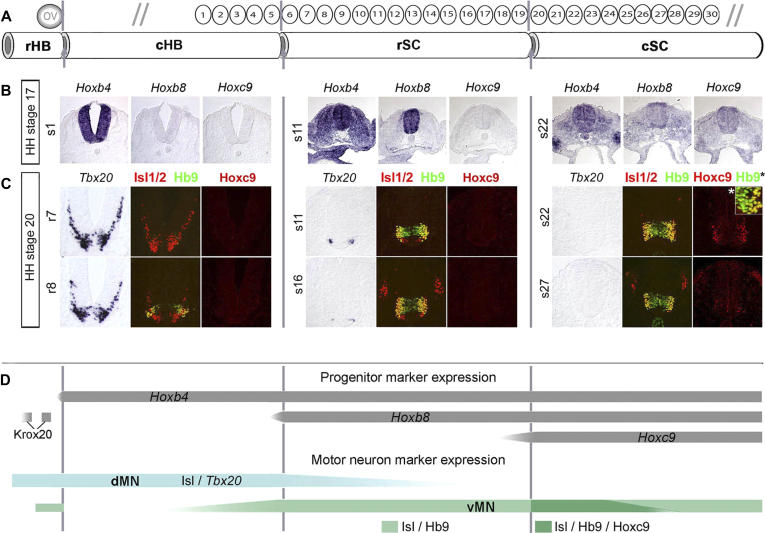
Profiles of
Hox Gene Expression, dMNs, and vMNs in the Hindbrain and Spinal Cord
(A) Schematic figure of the caudal embryonic neural tube divided into four distinct regions along the rostrocaudal axis: rHB; r7 and r8 defined as cHB; the region of the spinal cord located at the level of somite 6–19 defined as the rSC; and the region located caudal to somite 19 defined as cSC.(B) In a stage 17 (30-somite) chick embryo, the rostral borders of
Hoxb4, Hoxb8, and
Hoxc9 expression are located just caudal to the otic vesicle (OV) (at the level of the r6/7 border), at the level of somite 5/6, and at the level of somite 19/20, respectively.
Hoxb4 expression in the absence of
Hoxb8 and
Hoxc9 is characteristic of cells in the cHB (r7 and r8). Expression of
Hoxb4 and
Hoxb8 in the absence of
Hoxc9 is characteristic of the rSC domain, and expression of
Hoxb4, Hoxb8, and Hoxc9 is characteristic of cells in the cSC domain.
(C) In stage 20 (42-somite) chick embryos, the rostral boundaries of expression of
Hoxb4, Hoxb8, and
Hoxc9 in the neural tube are maintained as in a stage 17 embryo (± 1-somite).
Tbx20
+/Isl
+ dMNs are present at high numbers in the cHB and at lower numbers in the rSC. No
Tbx20
+/Isl
+ dMNs are found in the cSC. In contrast, Hb9
+/Isl
+ vMNs are present at high numbers in both rSC and cSC, and at lower numbers in r8 of the cHB. Hoxc9 protein is expressed in a subset of Hb9
+/Isl
+ vMNs in the cSC and thus, distinguishes vMNs in the cSC from vMNs in the rSC.
(D) Horizontal bars represent rostrocaudal restrictions (applied to
Figure 1A) of marker genes expressed by neural progenitor cells in the stage 17 neural tube, and by MNs in stage 20 embryos.